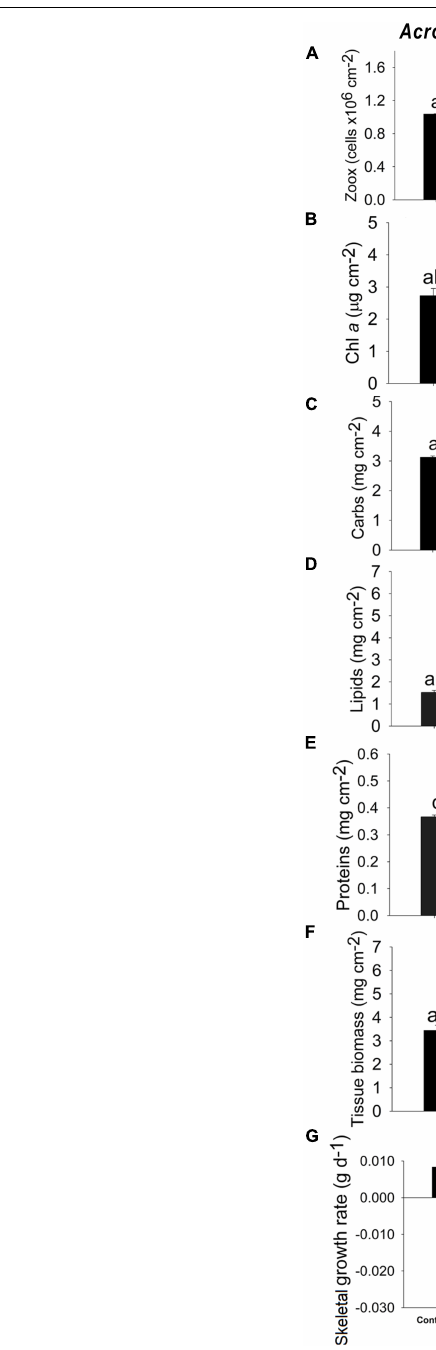
for tissue biomass ( Table 2 ; Figure 5A ). For P. cylindrica , factor 1 and factor 2 described 55.8 and 27.0% of the variance ( Table 2 ), respectively. Factor 1 was characterized by high positive